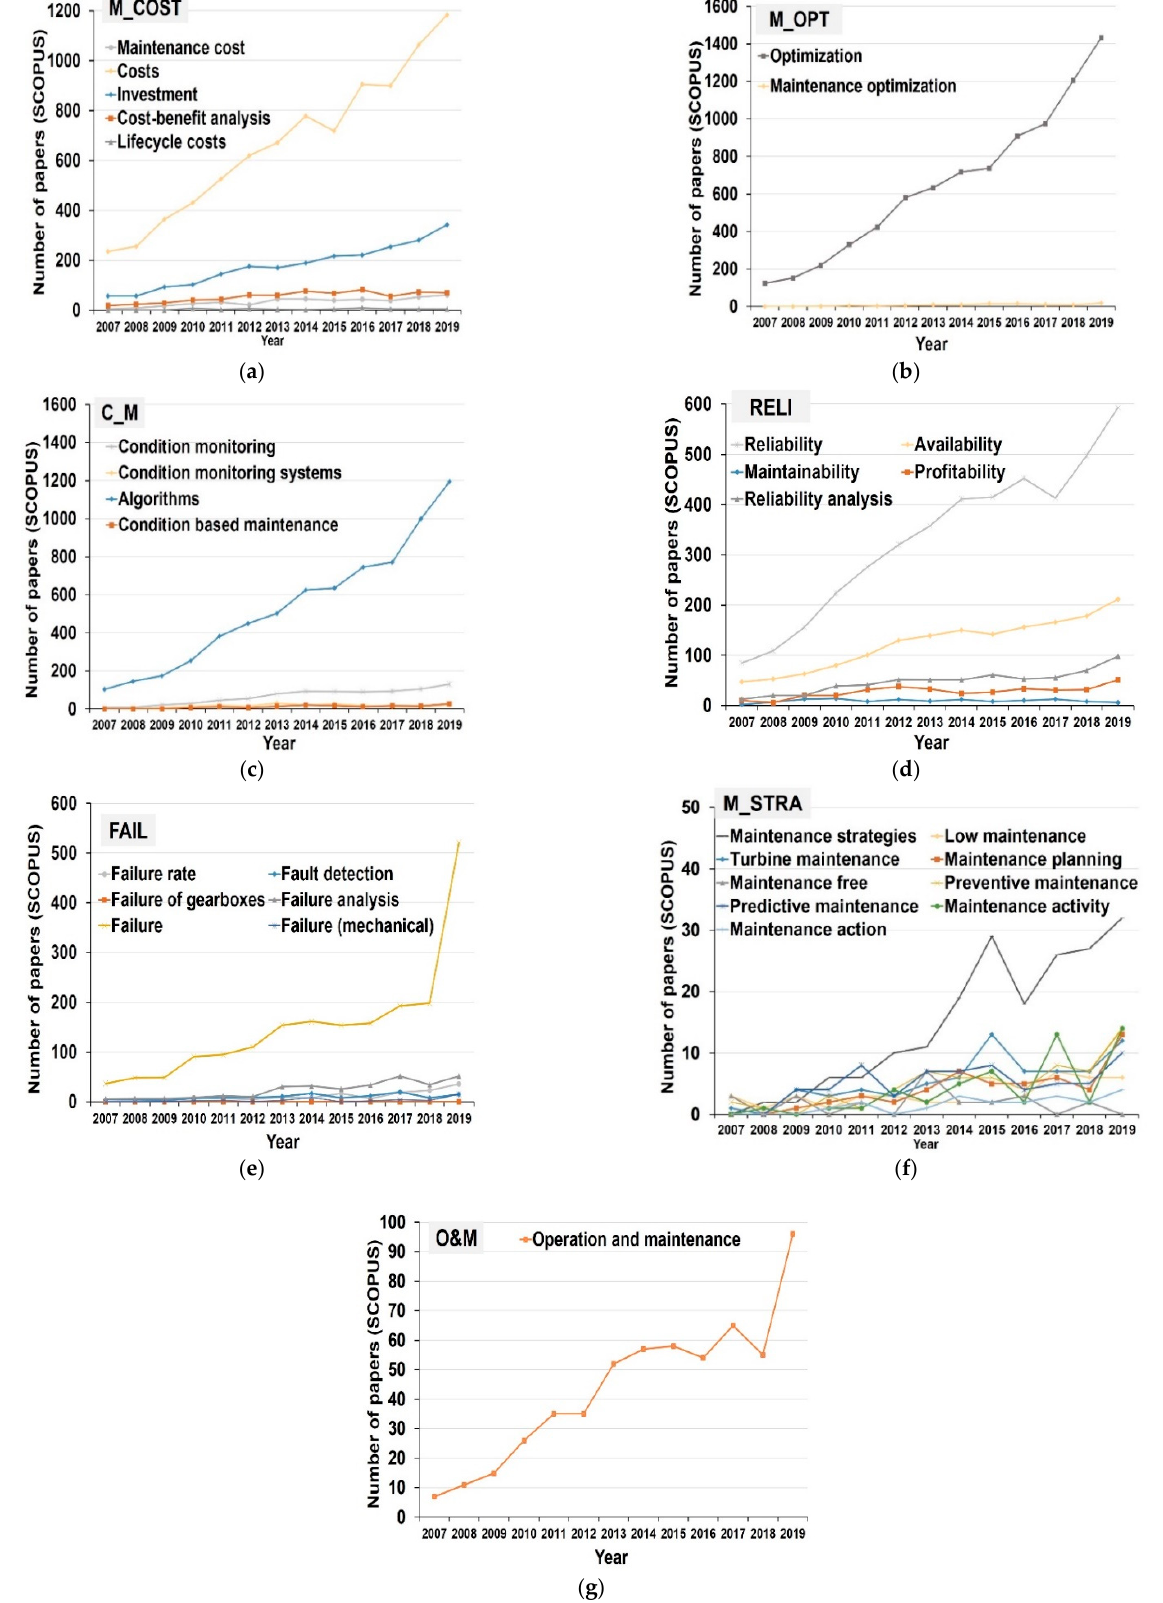
Figure 4. Wind energy O&M variables and number of papers in Scopus: ( a ) M_COST; ( b ) M_OPT; ( c ) C_M; (d) RELI; ( e ) FAIL; ( f ) M_STRA; ( g ) O&M.